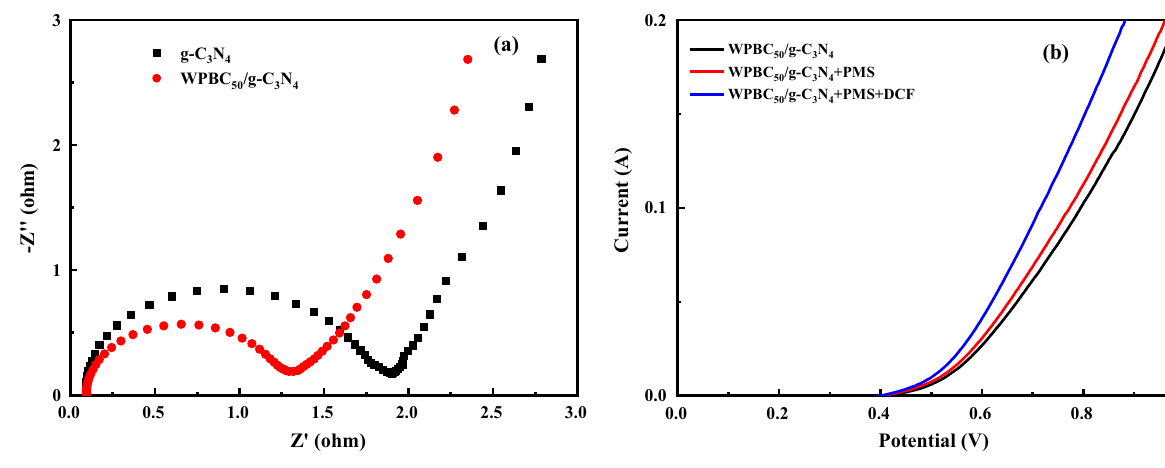
Fig. 9 a Electrochemical impedance spectra analysis and b linear sweep voltammetry analysis of different